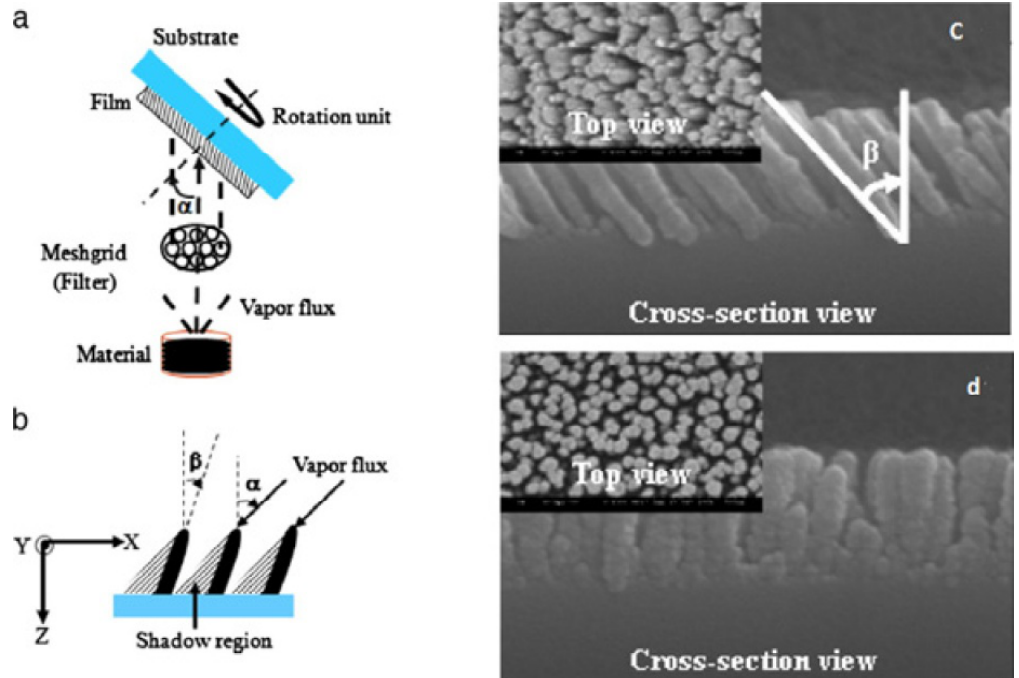
Fig. 4. (a) The schematic illustration of the GLAD technique (glancing angle deposition) and (b) column growth orientations and vapour flux with angle definitions:  represents the angle for deposition and  represents the column angle, c) The electron micrograph scan of the nanostructured porous SiO ëÜÝ×Ü ëÕç äéè ãâ çèÕèÝãâÕæí ÕâØ Ø£ ©§ª æäá æãèÕèÝâÛ ËÝ ¢ª©©£ çéÖçèæÕèÙç Õè ±®°§ ÊÙäæÝâèÙØ ëÝèÜ äÙæáÝççÝãâ from K. Sobahan, Y. J. Park, J. J. Kim and C. K. Hwangbo // Optics Communications 284 (2011)